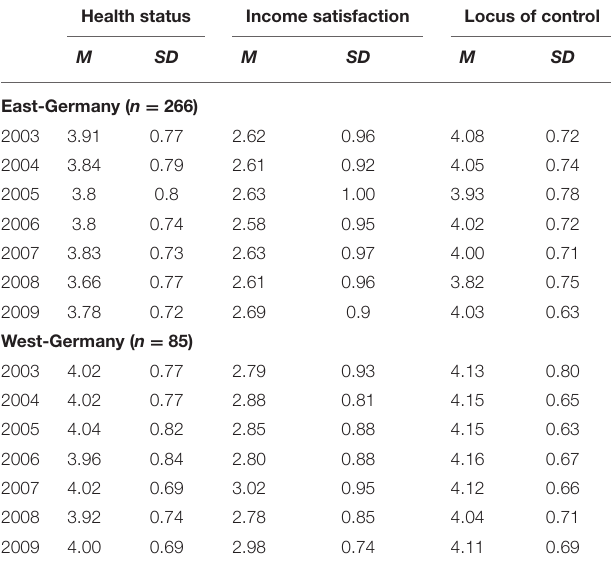
TABLE 3 | Descriptive statistics of subjective health status, satisfaction with income, and locus of control for individuals in East- and West-Germany across